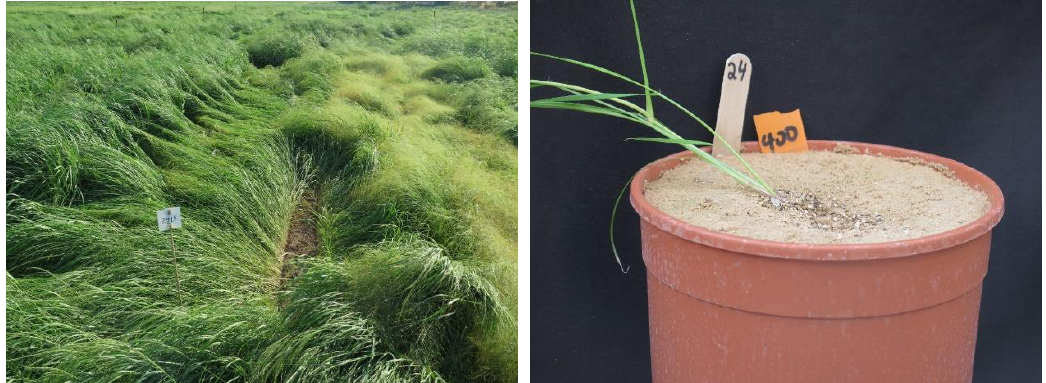
Figure 1. Root lodging in tef grown in field plots (left) and pot (right).